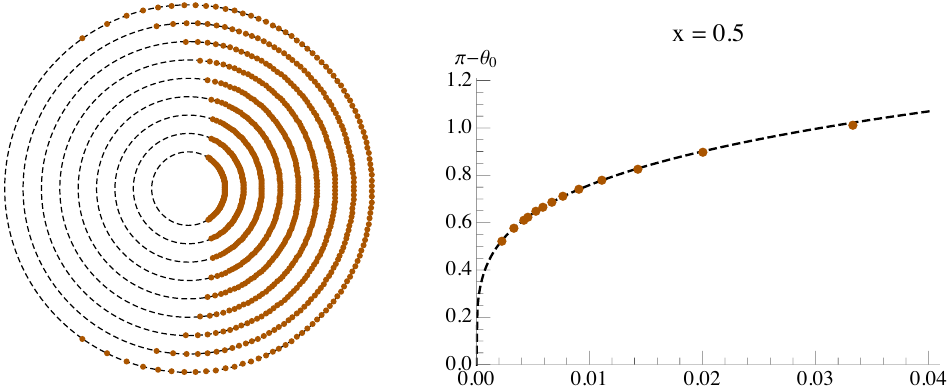
Figure 1 . Finite N solution of the discrete phase equation (2.1). Left: roots of (2.1) for N = 100 drawn as phases on circles of di(cid:11)erent radii. The outmost circle has x = 0 : 5, while the inner circles have x increased in steps 0 : 05 up to x = 0 : 9. Right: gap half-width (cid:25) (cid:0) # 0 evaluated at x = x H with increasing N up to 450. The dashed line is a power law (cid:12)t providing an exponent very close to 1 = 4, i.e. # 0 ( x H ) = (cid:25) + O ( N (cid:0) 1 = 4